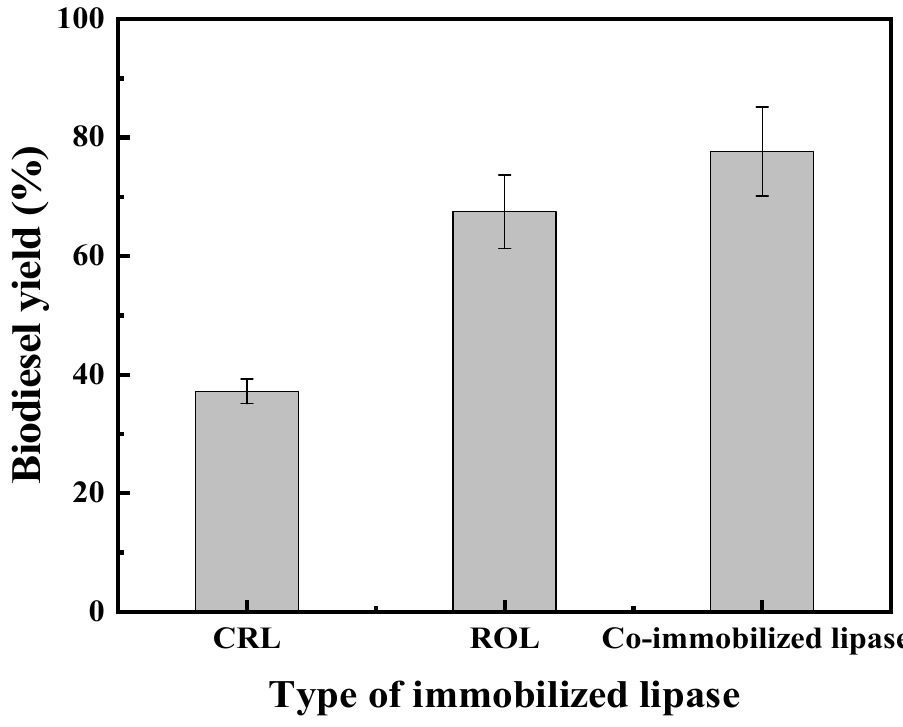
Figure 8. Transesterification of WCO using single and co-immobilized lipases under the following parameters: 4:1 molar ratio of methanol to oil (methanol was added 3 times at intervals of 40 min); 20% isooctane; 5% water content; 10% immobilized lipase; 40 ± 1 °C; 120 min reaction time; under ultrasound-assisted parameters of 40% power and 40 kHz frequency (all % based on oil weight).